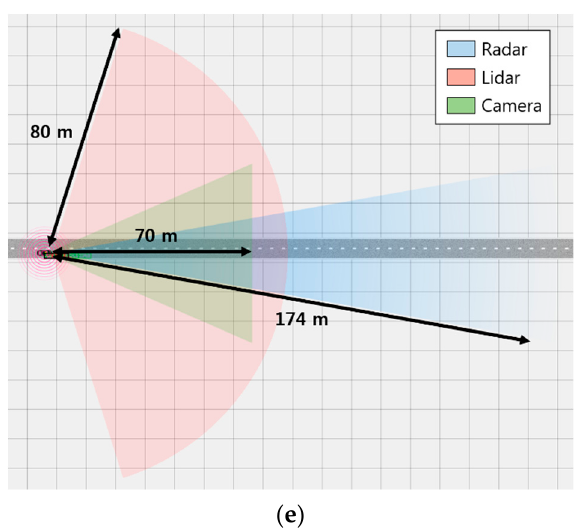
Figure 5. Locations of the sensors installed on the host vehicle and the sensor coverage. ( a ) Radar; ( b ) lidar; ( c ) camera; ( d ) GNSS antenna; ( e ) sensor range and FOV.